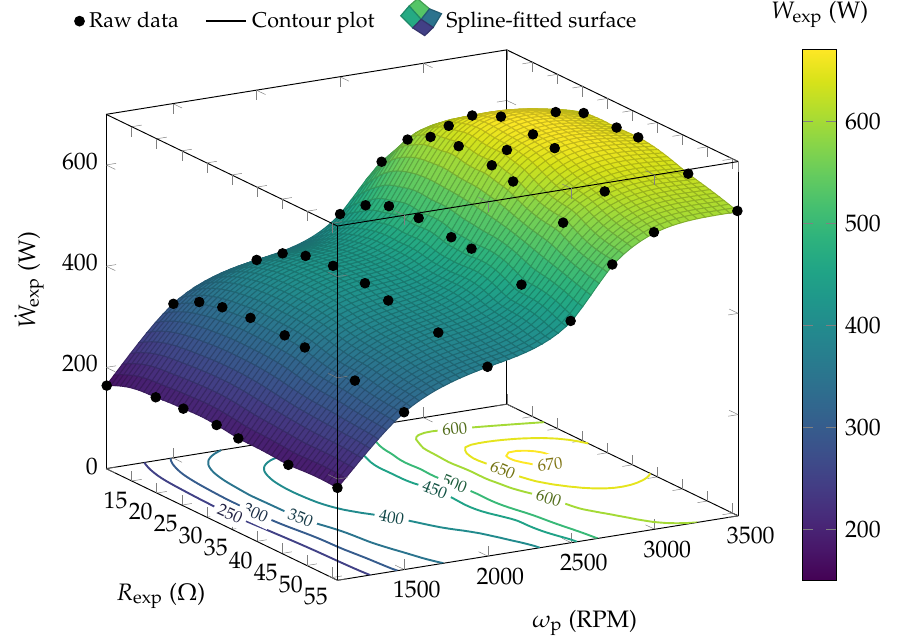
Figure 3. ORC gross power output part-load performance map as function of the pump speed, ω p , and the expander load, R exp for a heat-source temperature set at 140 ◦ C.